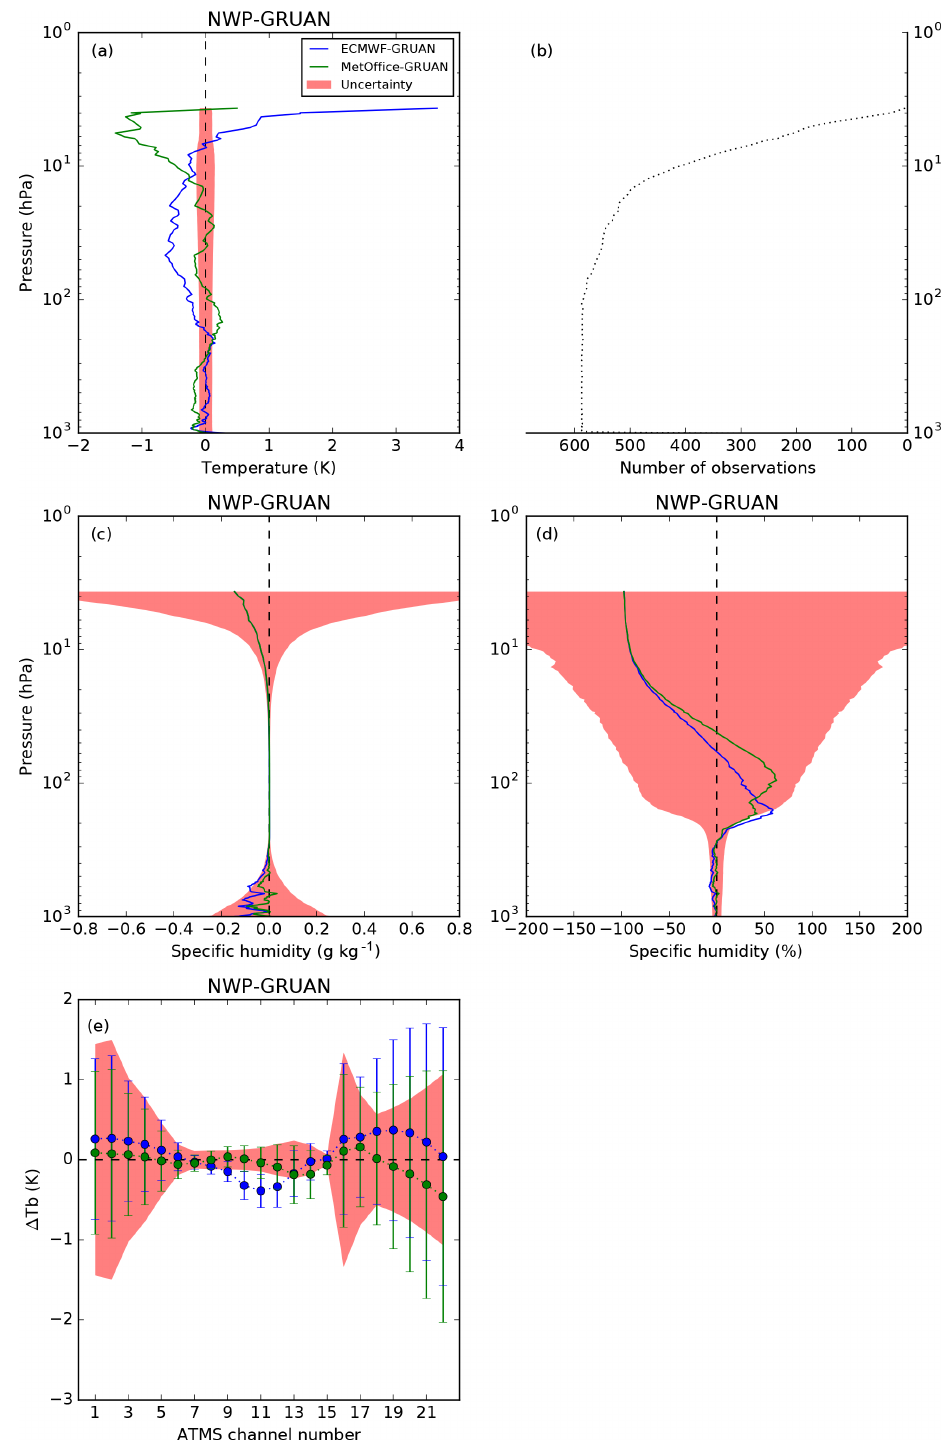
Figure 5. Same as Fig. 4 but for the 587 night-time